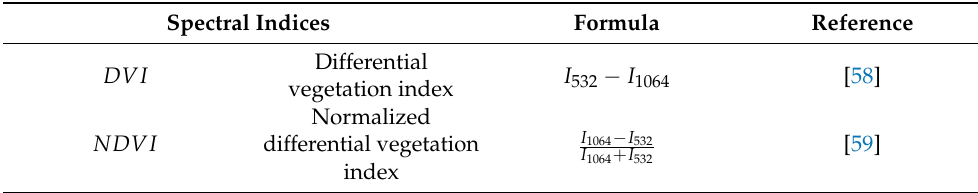
Table 2. Spectral exponential framework